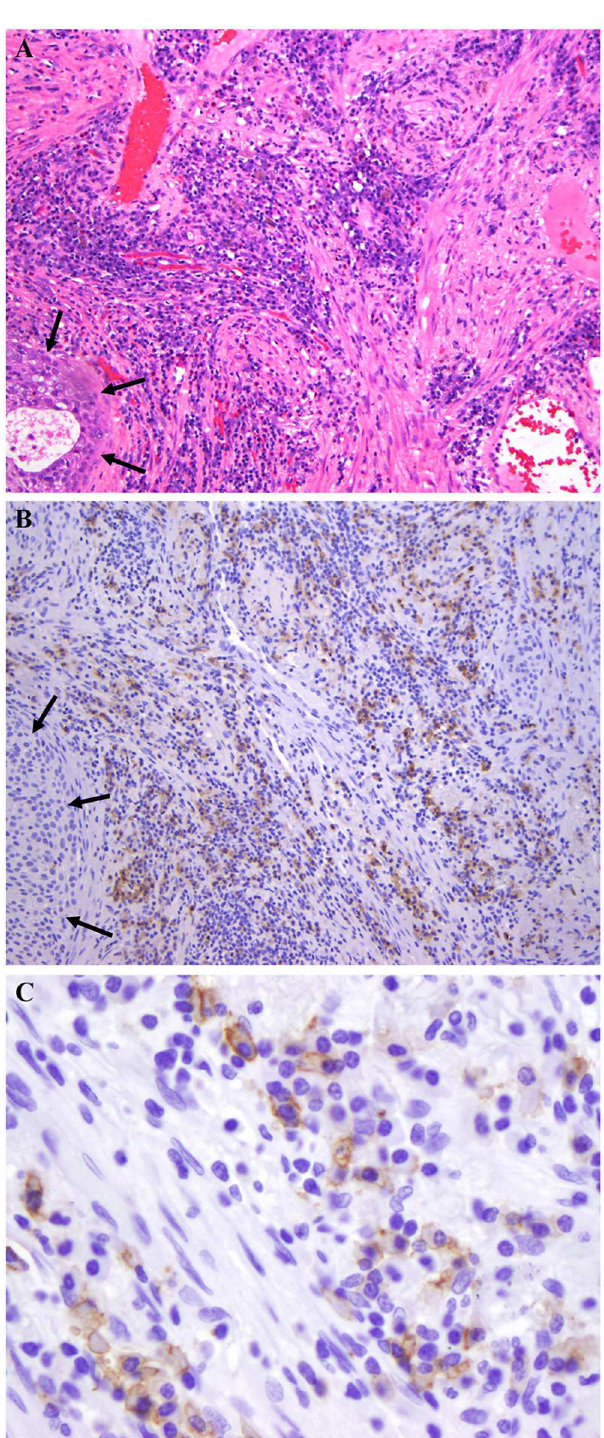
Fig 3. Inflammatory cells within non-neuroendocrine tumor. A. Hematoxylin and eosin stain of squamous cell carcinoma (black arrows) with abundant plasma cells. B. SSTR2A IHC stain showingnegativetumor staining(black arrows) but positive staining in inflammatory cells (originalmagnification 100X). C. High power field shows tumor (black arrows) with SSTR2A IHC membranous stainingin plasma cells (white arrows).